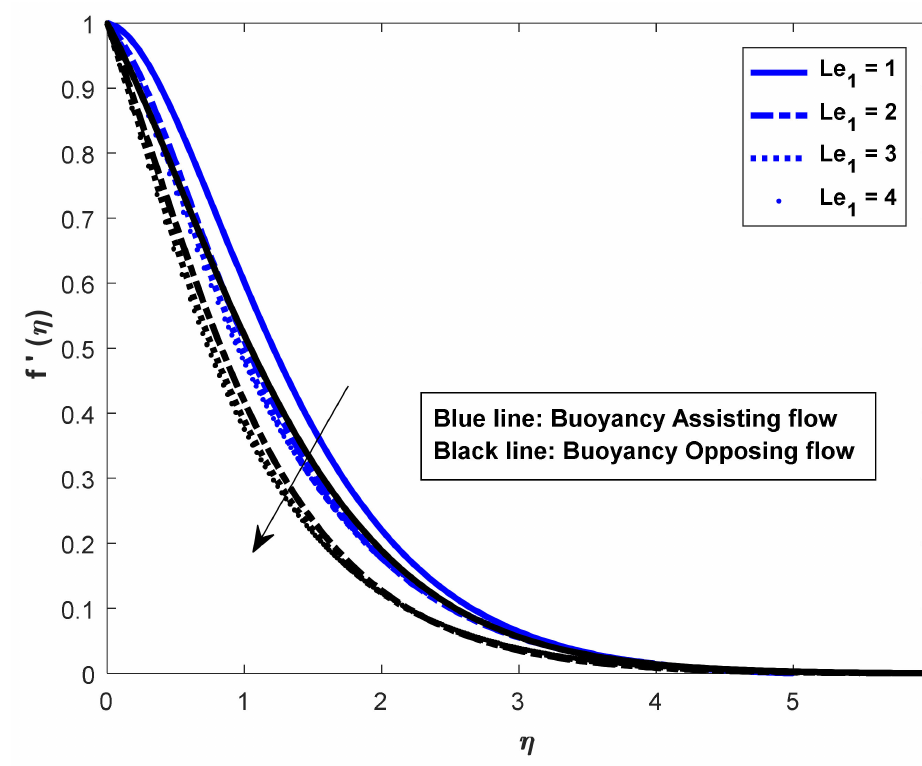
Figure 21. Le 1 on